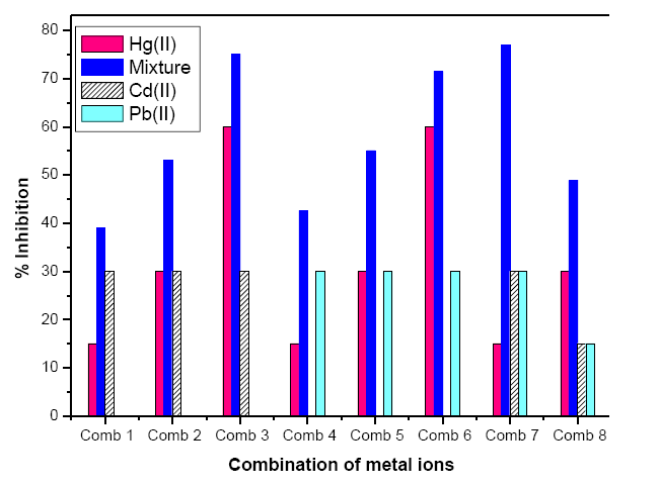
Figure 6 . Combined effect of Hg (II), Cd (II) and Pb (II) concentration on enzyme activity at optimized inhibition time. For each combination, concentrations corresponding to IC values are taken. First column corresponds to Hg(II), second to mixture, third column to Cd(II) and fourth to Pb(II). Pb(II) is absent in first three combination, whereas Cd(II) is absent in combination 4, 5 and